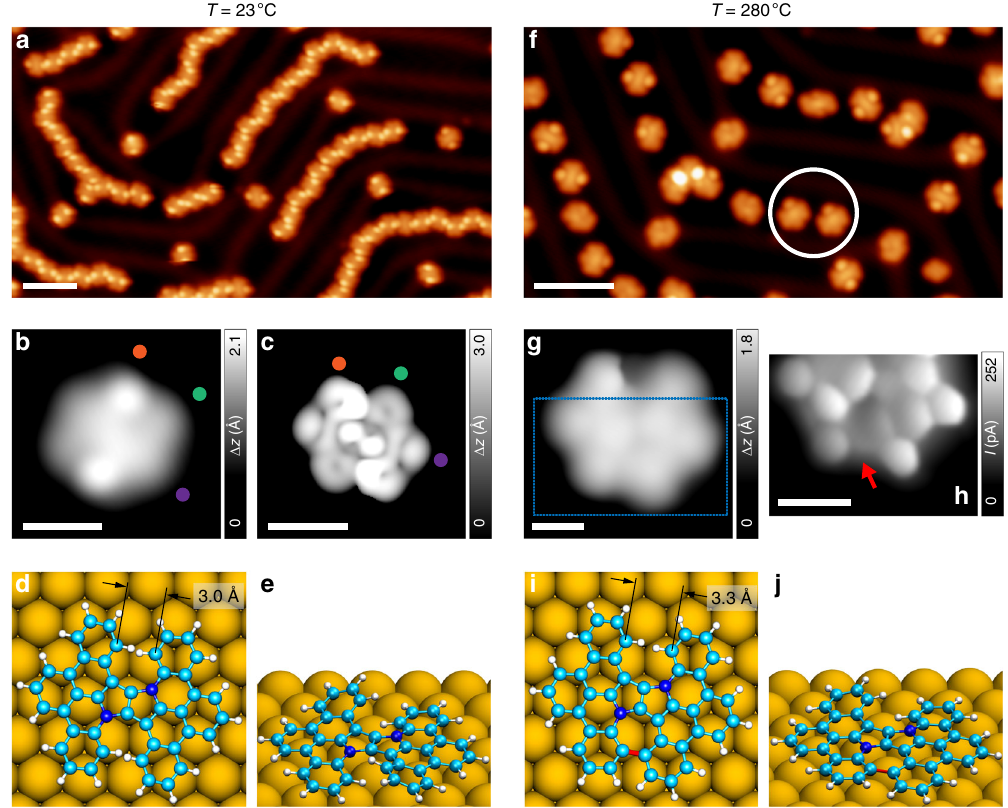
Fig. 2 On-surface reaction of 6a on Au(111). a Overview STM topography image of the surface after room temperature deposition of 6a , revealing the coexistence of predominant chains running along fcc domains, and isolated molecules ( V = − 1 V, I = 10 pA, scale bar: 5 nm). b High-resolution STM image ( V = − 0.1 V, I = 50 pA, scale bar: 1 nm) and c DFT-simulated STM image ( V = − 0.2 V, scale bar: 1 nm) of 6a . The colored dots serve as a guide to the eye for comparing the intramolecular features in experimental and simulated STM images. d , e Top and side views of the DFT equilibrium geometry of 6a . f Overview STM topography image of the surface after annealing to 280 °C ( V = − 1 V, I = 10 pA, scale bar: 5 nm). The white circle highlights the half-closed species 7a , presenting only one lobe. g High-resolution STM image of 7a acquired with a CO tip ( V = 10 mV, I = 50 pA, scale bar: 0.5 nm). The blue rectangle marks the acquisition area of the UHR-STM image. h Corresponding UHR-STM image of 7a (open feedback parameters: V = 5 mV, I = 50 pA; Δ z = − 50 pm; scale bar: 0.5 nm). The red arrow indicates the heptagonal ring formed after this annealing step. i , j Top and side views of the DFT equilibrium geometry of 7a . The newly formed bond at this annealing step is highlighted in